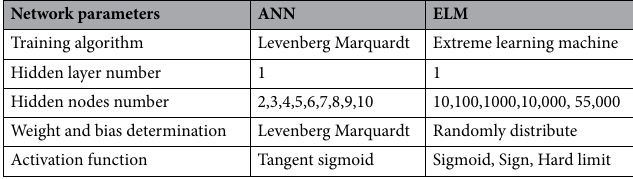
Table 3. Network tuning parameter.